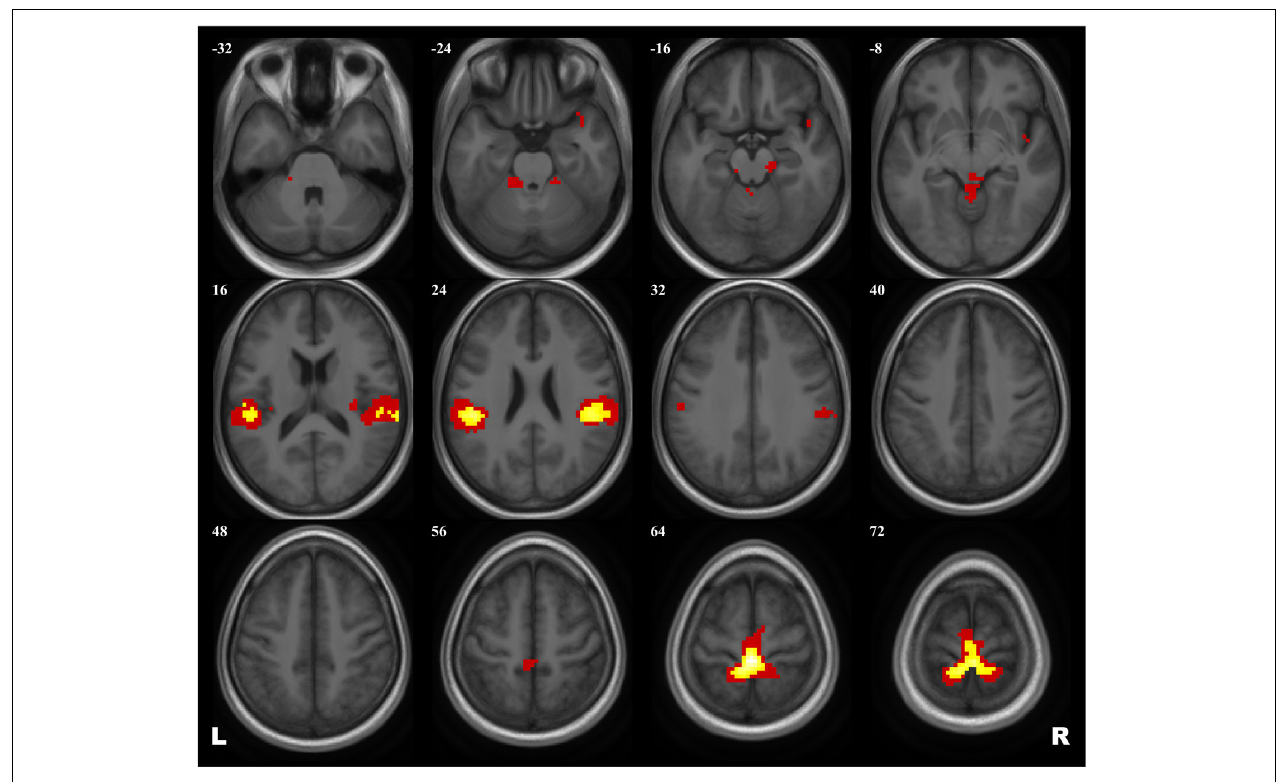
FIGURE 2 | Group map of the activation elicited by plantar stimulation in all participants (both cosmonauts and healthy controls). Yellow areas depict activation at a reliable statistical threshold (cluster-wise FDR correction, q < 0.05, p < 0.05; voxel-wise cluster-defining threshold, p < 0.001 uncorrected). Activation at a lenient statistical threshold ( p < 0.05 uncorrected voxel-wise, k = 5) is shown in red. The statistical images are presented as overlays upon the average structural image of all participants converted to the MNI space.